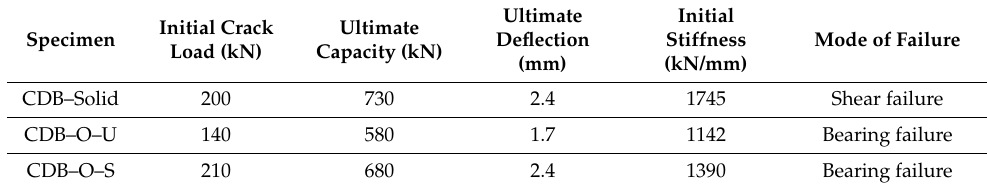
Table 4. Summary of the experimental results.